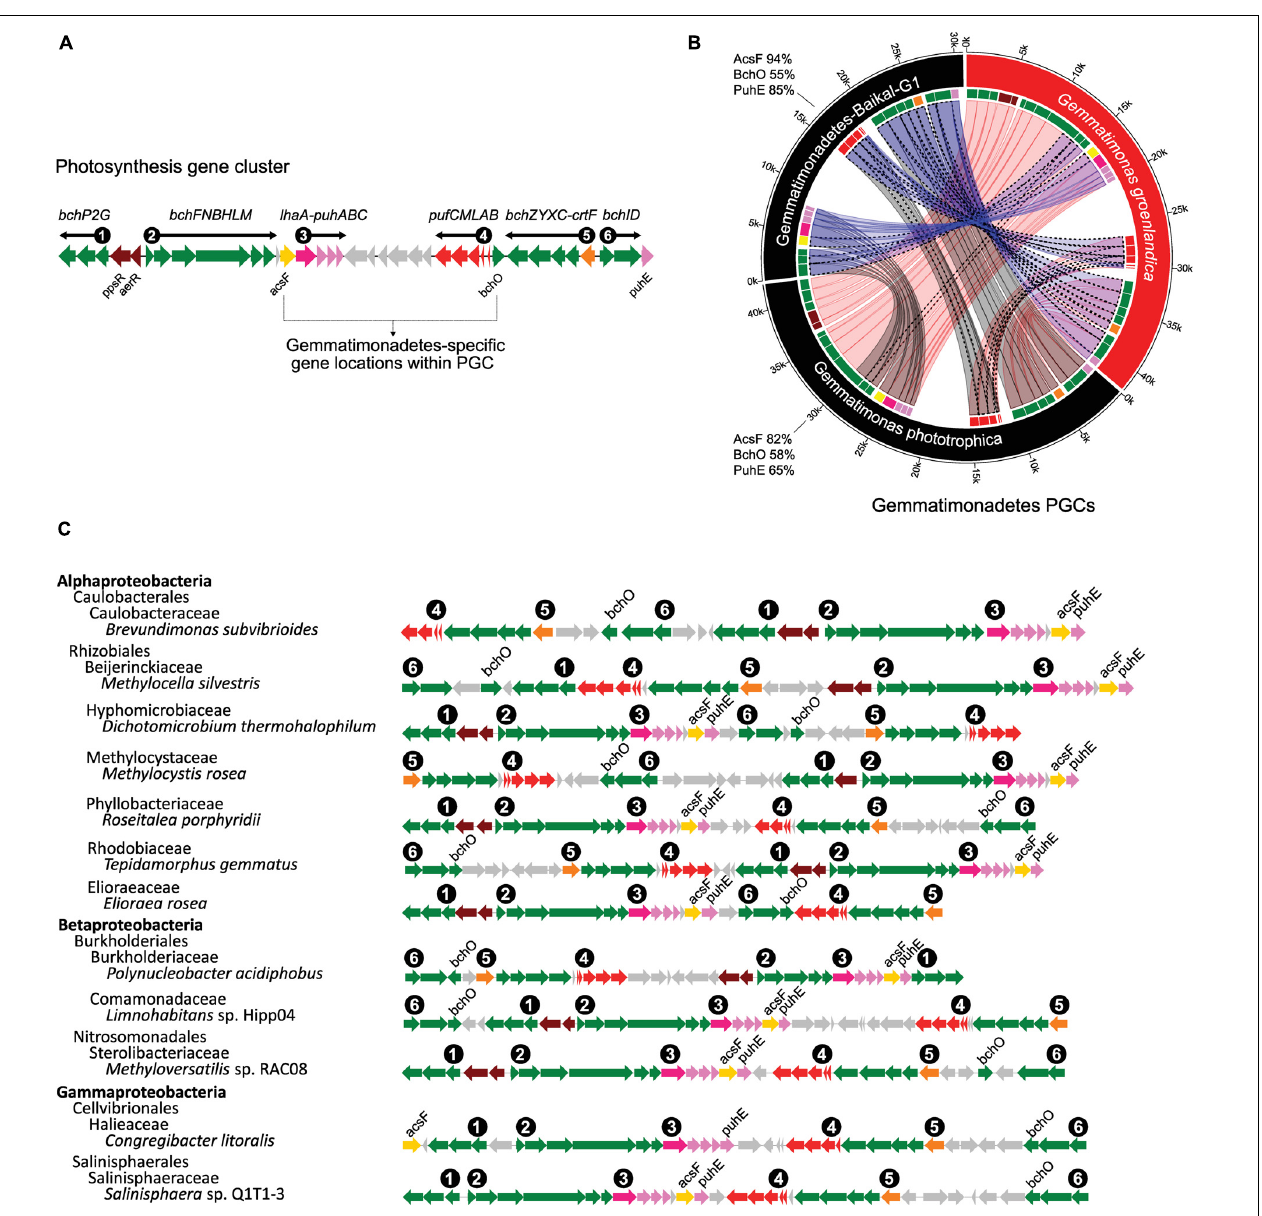
FIGURE 7 | Conserved and unique gene organization of photosynthesis gene cluster (PGC) in chlorophototrophic Gemmatimonadetes bacteria. (A) , six gene sub-clusters commonly found in photosynthesis gene clusters. bch and acsF , bacteriochlorophyll biosynthesis genes; puf , genes encoding reaction center proteins; puh , genes encoding reaction center assembly proteins; crt , carotenoid biosynthesis genes; lhaA , light-harvesting complex I assembly protein; ppsR and aerR , regulation related genes. Gray-colored genes are hypothetical ORFs with unknown function. The unique locations of acsF and bchO are highlighted. (B) , comparison of three known Gemmatimonadetes PGCs including two isolates ( G. phototrophica and G. groenlandica ) and a MAG, Gemmatimonadetes-Baikal-G1, reconstructed from a metagenome of the Baikal Lake in Russia (Cabello-Yeves et al., 2018). The same genes are connected by ribbons. A dotted outline of a ribbon represents > 90% protein sequence identity for the gene pair. The protein sequence identities of AcsF, BchO and PuhE in reference to G. groenlandica are shown next to the species arc. The fragmented Gemma-PGCs in the MAGs of this study were not included. (C) Representative PGC architecture in various proteobacterial genomes supporting the uniqueness of PGC in Gemmatimonadetes. Genomes were top tBlastn hits against NCBI’s RefSeq genome database using fused AcsF-BchO-PuhE protein sequences (see section “Materials and Methods”). One genome from each group at the class level was downloaded from NCBI. Only the top scoring genome from each class was kept as a